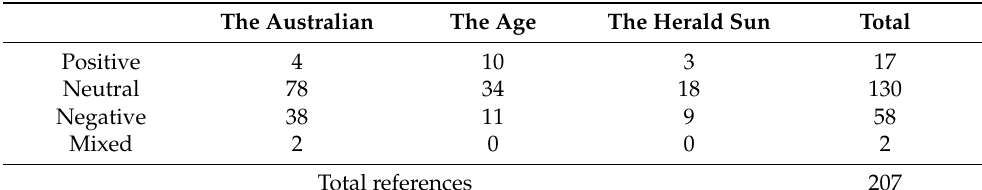
Table 9. Islam OR Muslim—tone of references coded across the